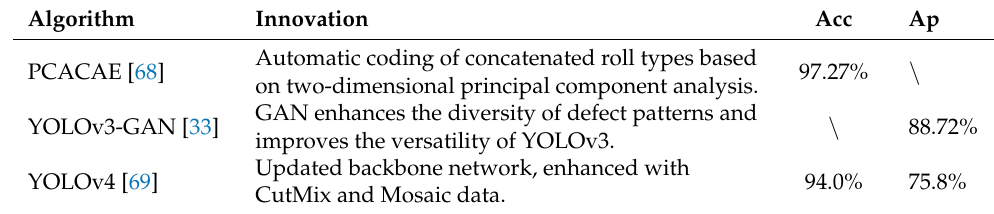
Figure 11. Schematic diagram of the structure of the one-stage detection network model. Table 4. Detection network model